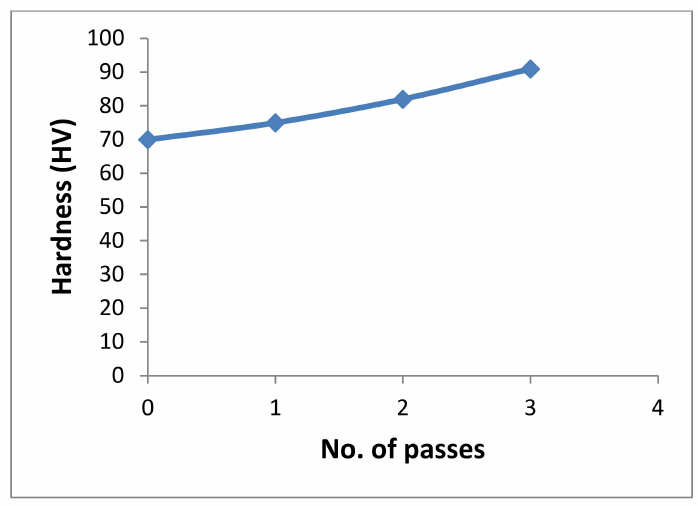
Figure 5. Vickers hardness of Al 5083 alloy before and after ECAP.